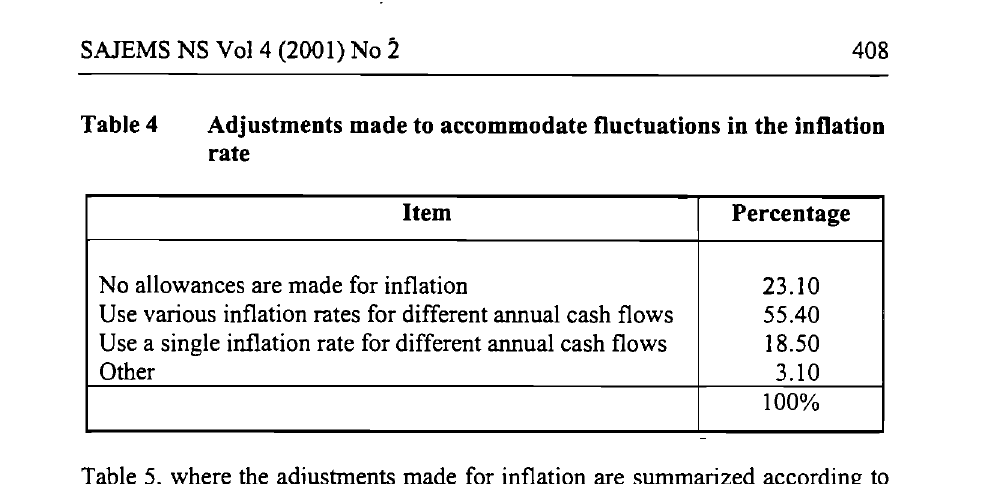
Inflation adjustments according to annual capital budget More RSOm R25m RIOm RSm R2m Less than to to to to to